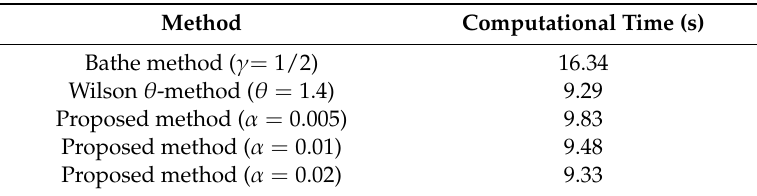
Table 3. Computational time of different methods.